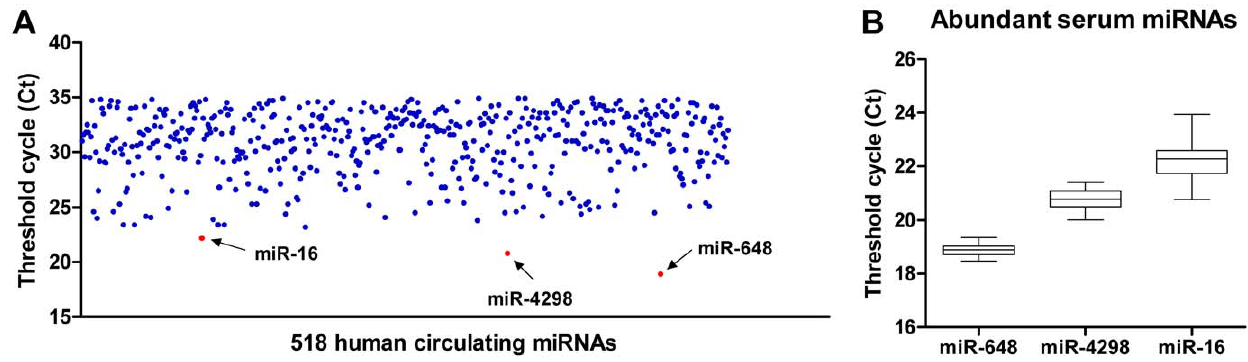
Figure 6. Expression profiling of human serum miRNAs. A: Pooled total RNAs from 40 healthy human serum samples were used to assay human 1,080 miRNAs in the miRBase 16.0. A scatter plot of 518 human serum miRNAs with Ct , 35 assayed by S-Poly(T) method was shown. Arrows indicate the most abundant miRNAs. B: Box-whisker plots of the three most abundant miRNAs, namely miR-648, miR-4298 and miR-16 in each healthy serum sample (n=40). The boxes indicate the 75th and 25th percentiles. The whiskers denote the lowest and highest values. The lines inside the boxes indicate the median values.